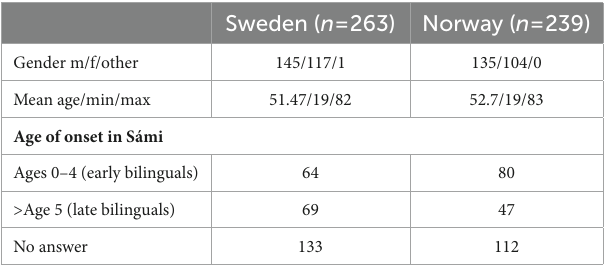
TABLE 5 Overview of ethnic Sámi participants in Stage II